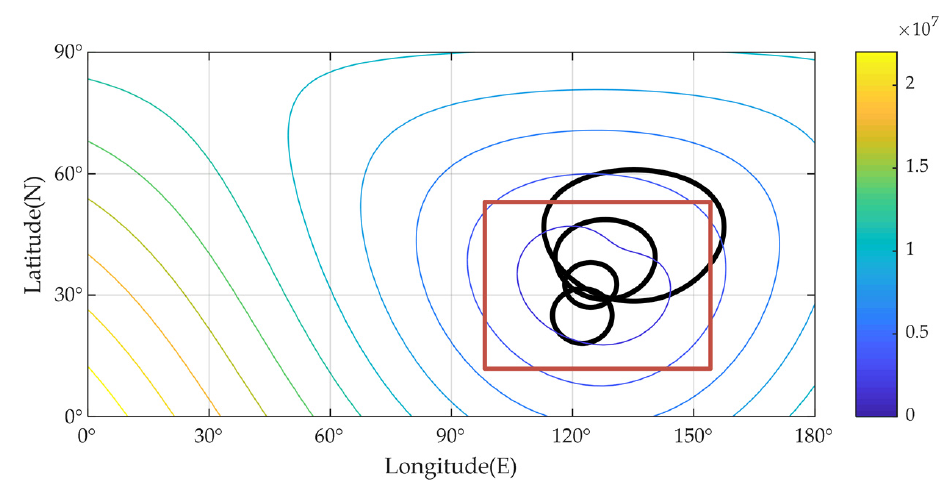
Figure 10. Contour line of F under feasible region D and feasible region D s . Table 5. Iterative process with initial value (0, 0, 0).